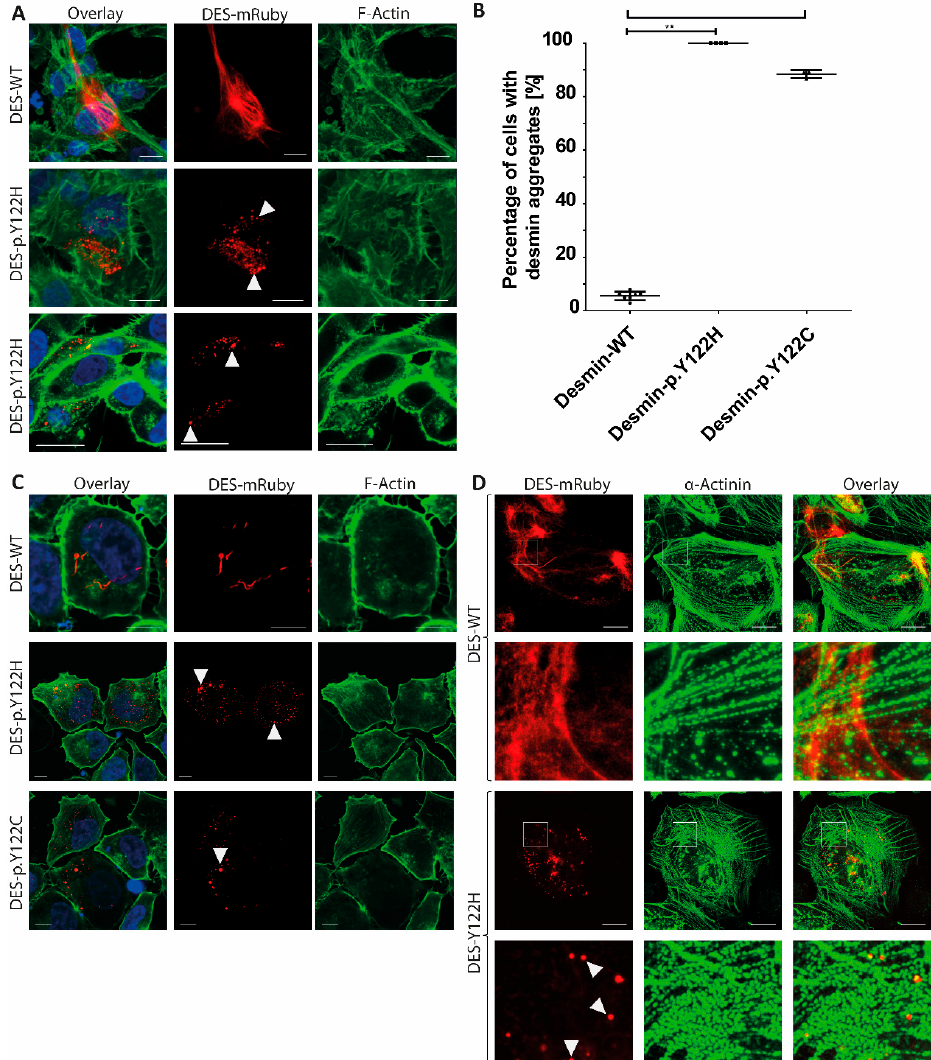
Figure 1. ( A ) Pedigree of the family. Circles represent females, squares represent males, and a slash denotes deceased. Black-filled symbols indicate a cardiac phenotype. Grey-filled symbols indicate individuals with skeletal myopathy. RCM, restrictive cardiomyopathy and +/+ indicates homozygous alleles. The index patient is marked with an arrow. Obligate carriers are indicated by small black circles. ( B ) Transthoracic echocardiography, four-chamber view. Note the enlarged size of both atria and the normal size of the ventricles. RA, right atrium; RV, right ventricle; LA, left atrium; and LV, left ventricle. ( C ) Transthoracic echocardiography, four-chamber view, pulsed wave Doppler of the mitral valve inflow. Note the restrictive flow pattern. ( D ) Transthoracic echocardiography, subcostal view. Note the enlarged inferior vena cava and hepatic vein (asterix). RA, right atrium and IVC, inferior vena cava. ( E ) Schematic overview of the next-generation sequencing analysis revealing p.Y122H. ( F ) Electropherogram of p.Y122H (III-1). ( G ) Schematic overview of the localization of known DES mutations within the desmin domain structure. Of note, p.Y122H (red arrow) is localized in a genetic hotspot of cardiomyopathy-associated DES mutations at the beginning of the coil-1 domain. ( H ) Partial sequence logo of desmin. Of note, p.Y122 is highly conserved (red arrow). For the complete alignment, see Figure S1. ( I ) Desmin dimer, modeled using Swiss-Model (PDB ID: 3S4R; [24]). Mutant tyrosine residues (p.Y122 and p.Y122’) are highlighted in blue and red. Residues of the heptad sequence are indicated in yellow.